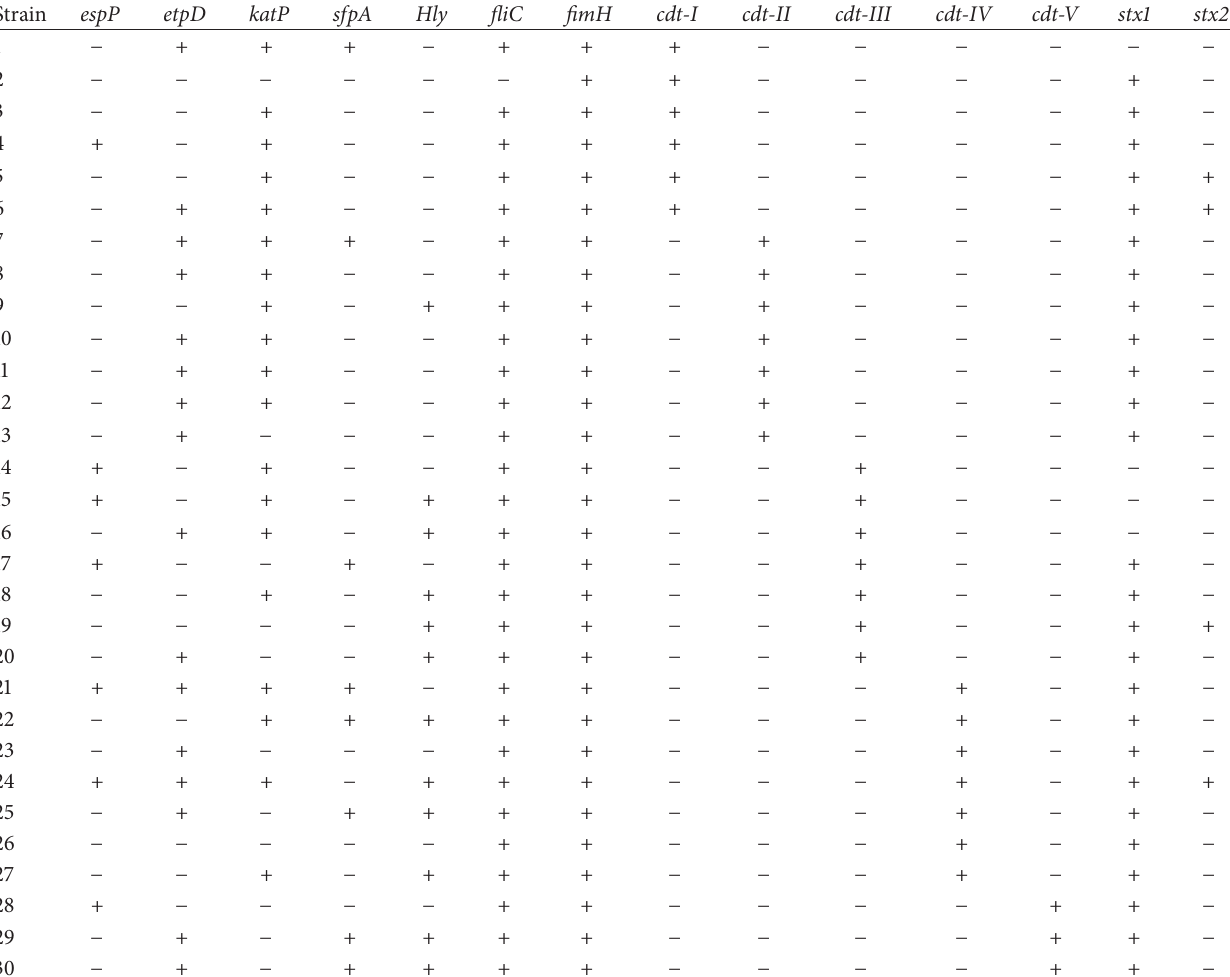
Table 2: The occurrence of virulence-associated genes including plasmid, Pathogenicity Island, chromosomal and phage genes. (+) indicates positive PCR product and the existence of mentioned gene while ( − ) indicates negative PCR product. Strain